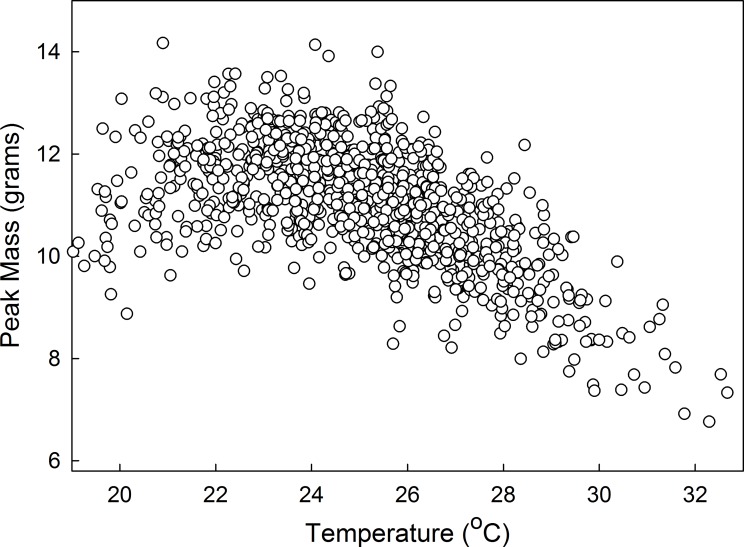
Inverse size-temperature relationship.Results of simulation with the mathematical model for a population of 1000 virtual individuals.